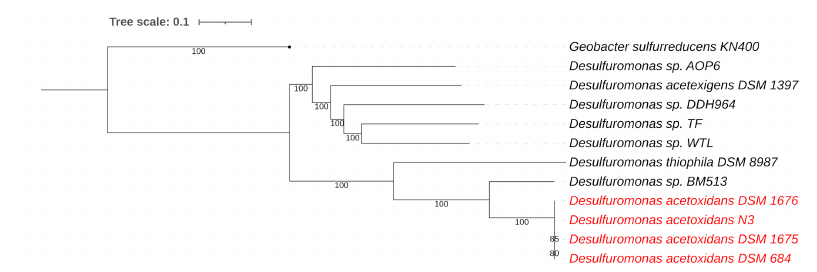
Figure 5. Whole-genome-based phylogenetic tree of all sequenced Desulfuromonas species.